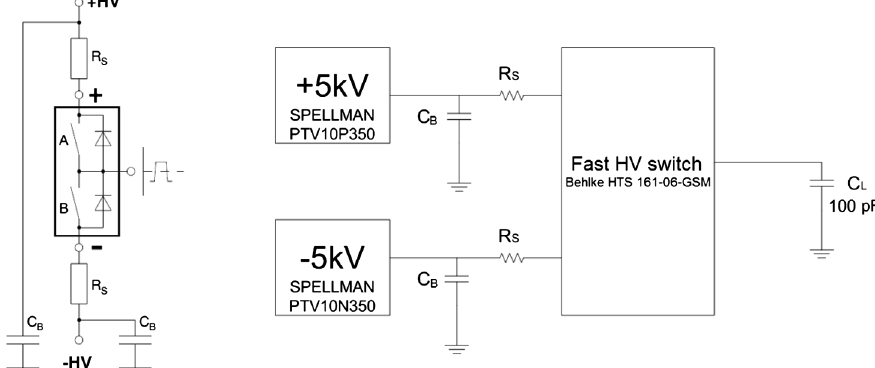
FIG. 6. Schematic diagram of (cid:2) HV for the deflection electrodes. The left side shows basic schematic diagram of push-pull HV switch. The right side shows the circuit implemented for the deflecting electrodes to enable fast chopper operation, where the capacitive load C L is provided by the deflection